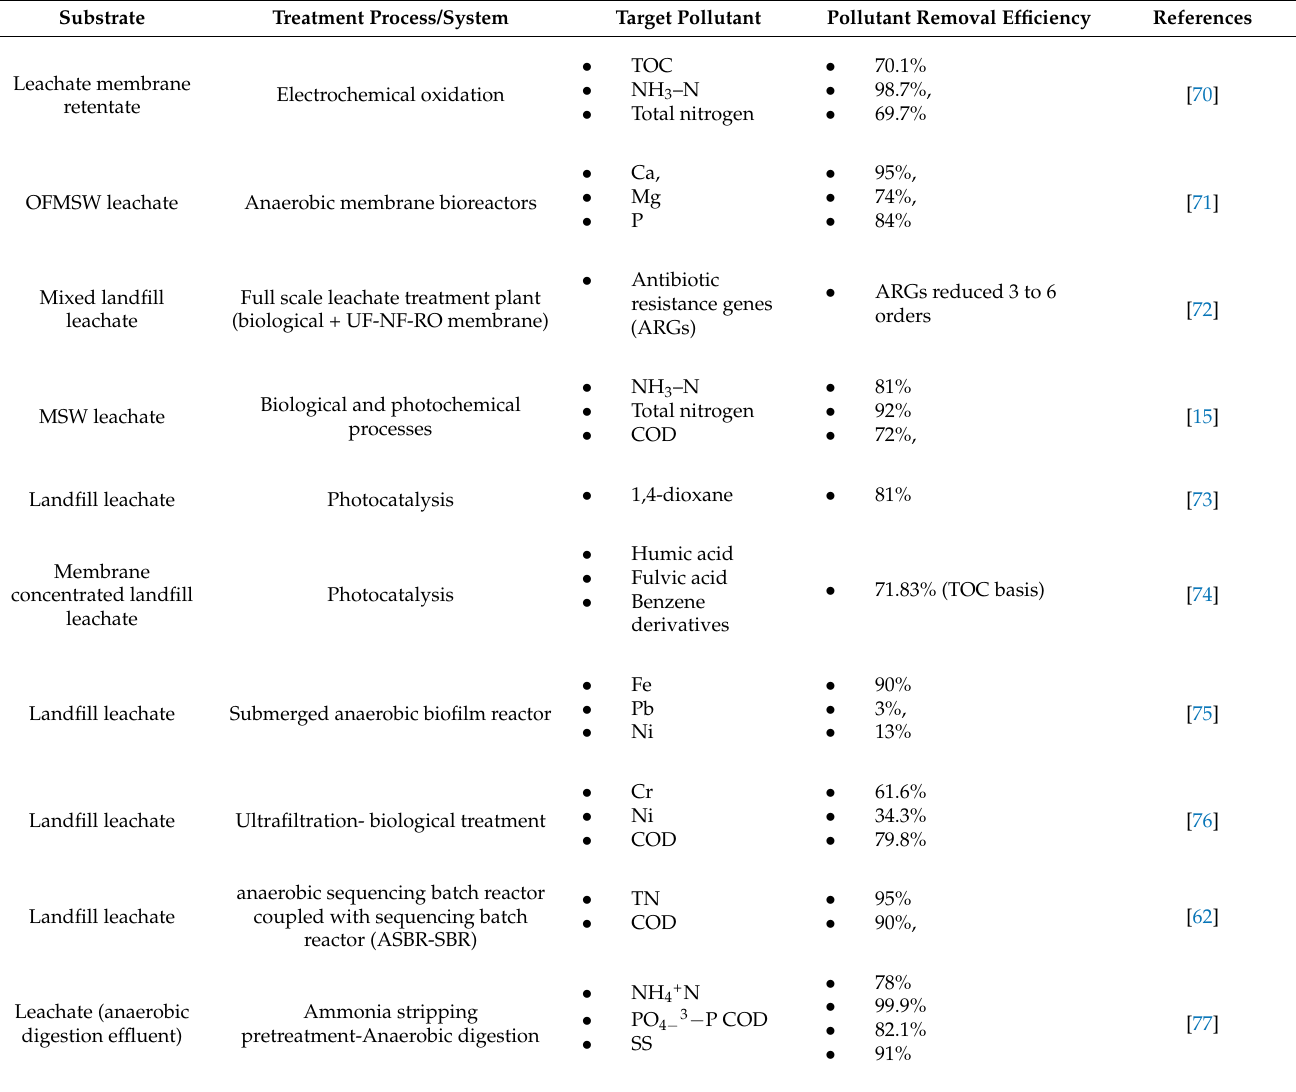
Table 3. Removal of pollutants from leachate during various treatment